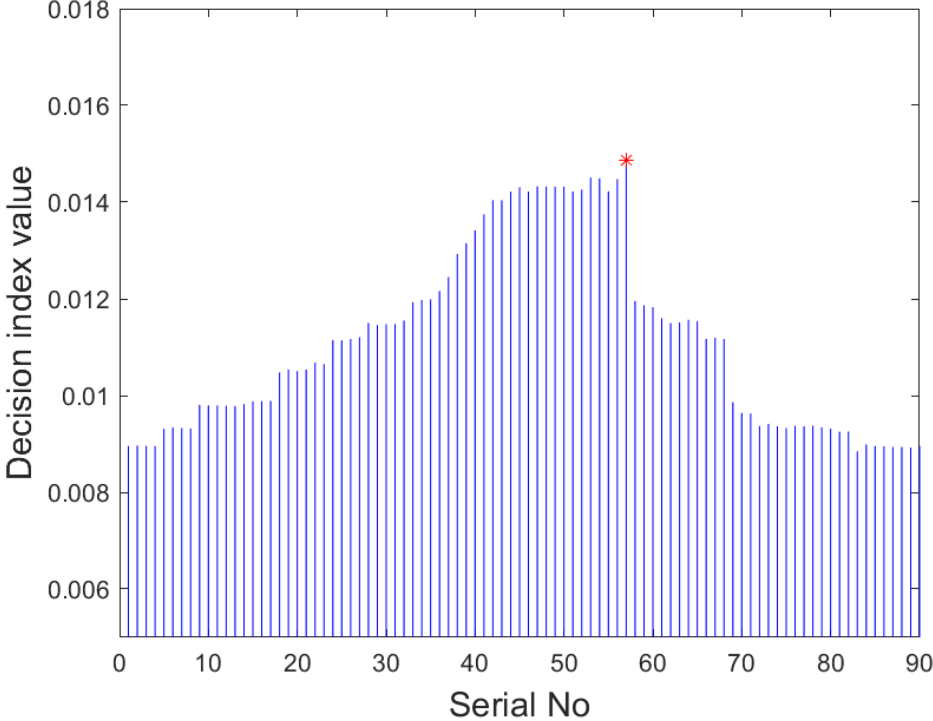
Figure 11. Multi-attribute decision indicators of each scheme.